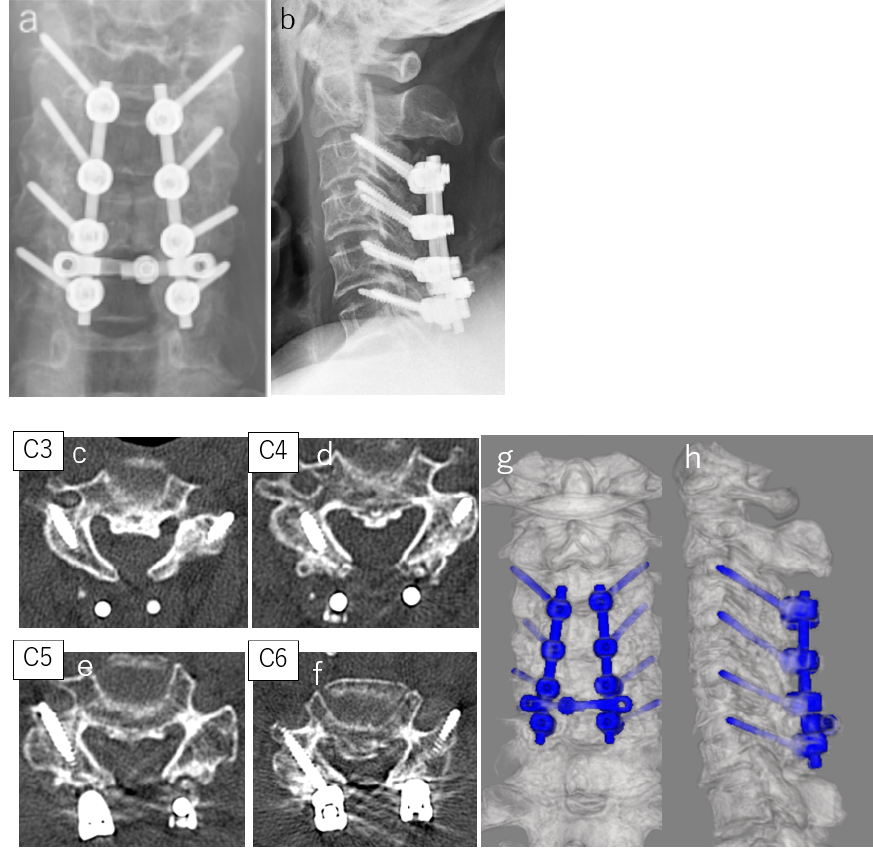
Figure 4. ( a ) postoperative X-ray frontal image; ( b ) lateral postoperative X-ray image; ( c ) postoper- ative CT axial image ( C3 ); ( d ) postoperative CT axial image ( C4 ); ( e ) postoperative CT axial image ( C5 ); ( f ) postoperative CT axial image ( C6 ); ( g ) postoperative 3DCT frontal image; ( h ) postoperative 3DCT lateral image.